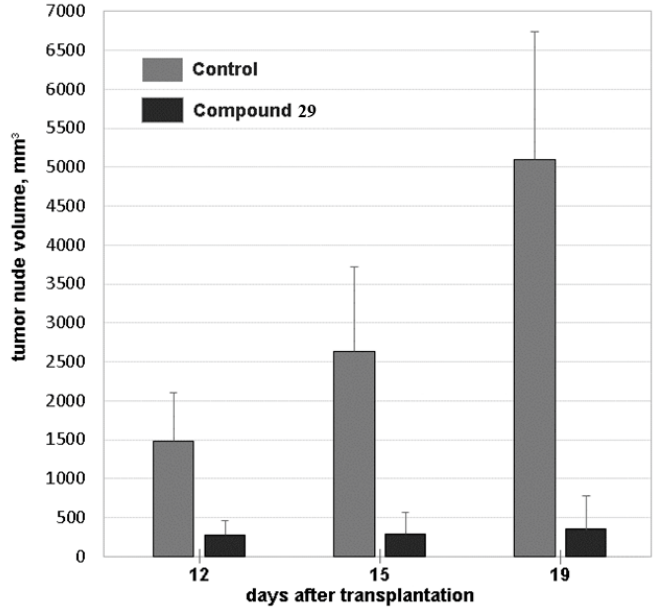
Figure 11. Changes in P388 nude volume upon the treatment with compound 29 (1000 mg/kg, o.d., 10 days, i.p.) as compared to the control group.